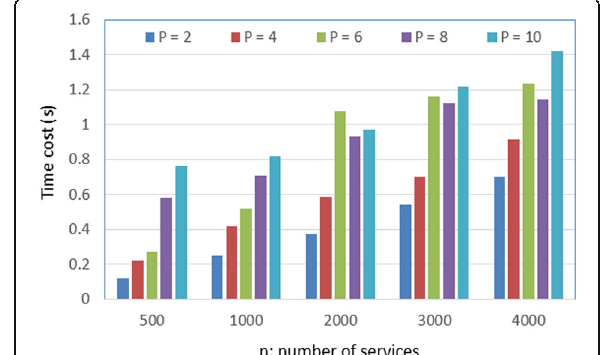
Fig. 4 Efficiency of Rec MPS w.r.t. n and P ( m = 142). P = 2, P = 4, P = 6, P = 8, P =